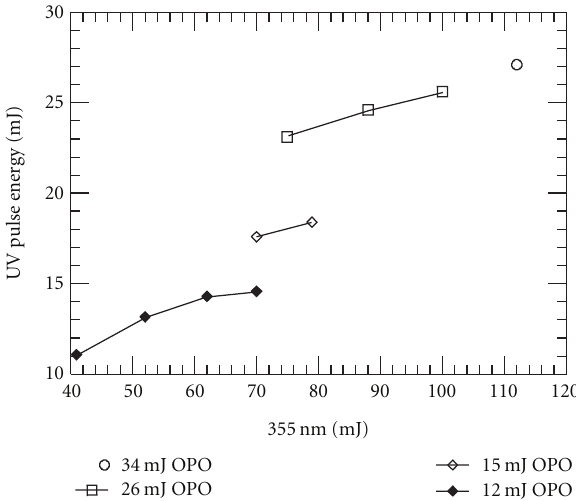
Figure 3: Measured energy of the generated UV pulse for di ff erent OPO signal and 3 ω pulse energies.